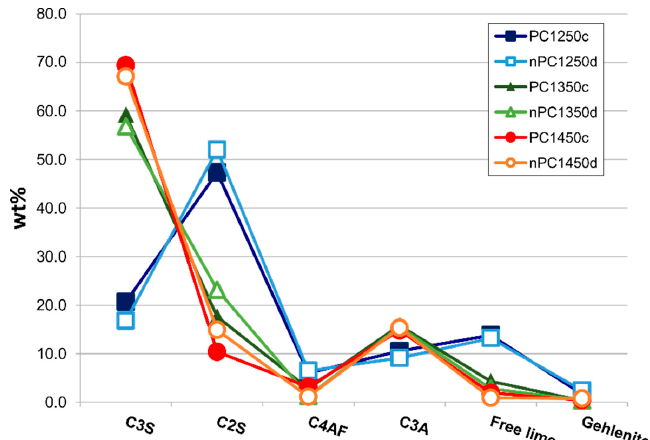
Figure 10. Spider diagram for the mineralogical quantitative analysis (Rietveld refinement Reference [46]) for the whole data set. Error bars in wt % are within the symbols.